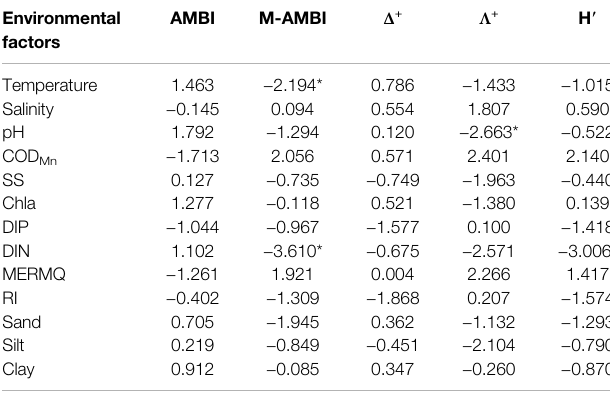
TABLE 2 | Results of regression analysis based on the generalized linear models (GLMs) between H ’ , AMBI, M-AMBI, Δ + , Λ + and environmental factors. Environmental